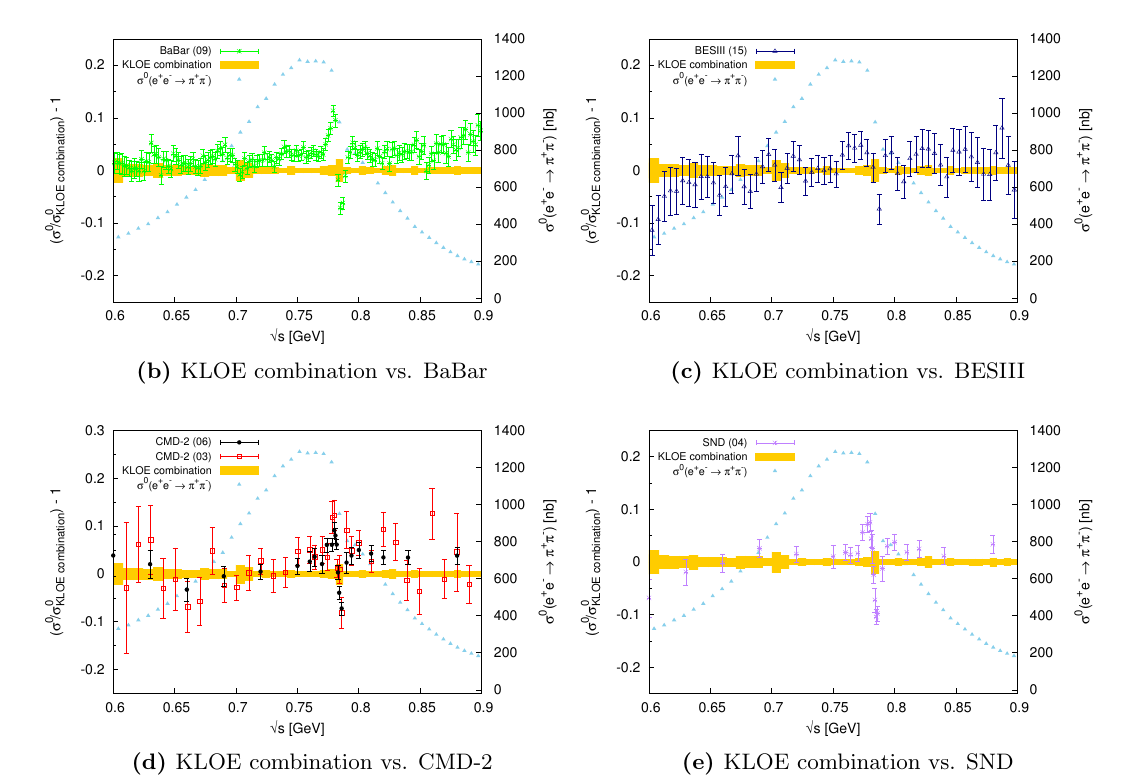
Figure 9. The (cid:25) + (cid:25) (cid:0) cross section from the KLOE combination compared to the CMD-2, SND, p BaBar and BESIII data points in the range 0 : 6 < s 0 < 0 : 9 GeV. The KLOE combination is rep- resented by the yellow band (colour online). In all cases, the uncertainties shown are the statistical and systematic uncertainties summed in